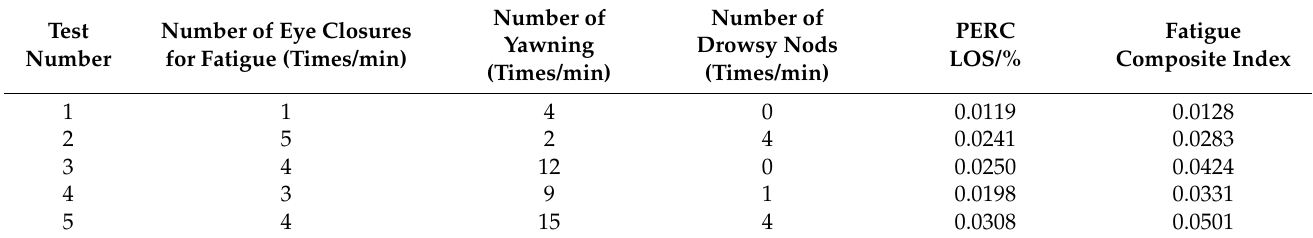
Table 6. Comprehensive fatigue index experiments.